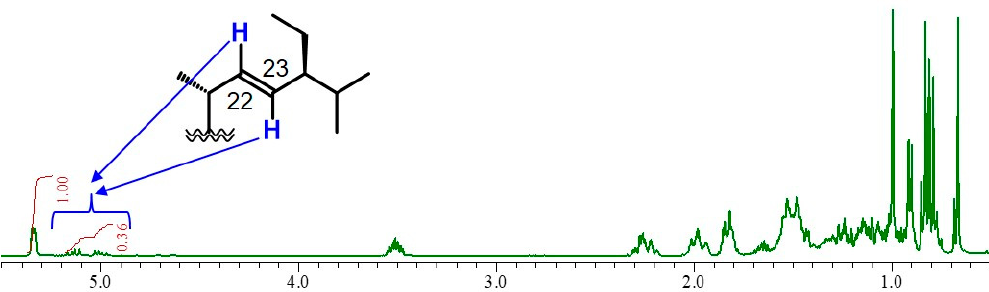
Figure 1. 1 H-NMR spectrum of the purified fraction. The 1 H-NMR spectrum showed that the purified fraction was sterol. The arrows show two characteristic signals of trans-protons attached to the C22–C23 double bond of stigmasterol.